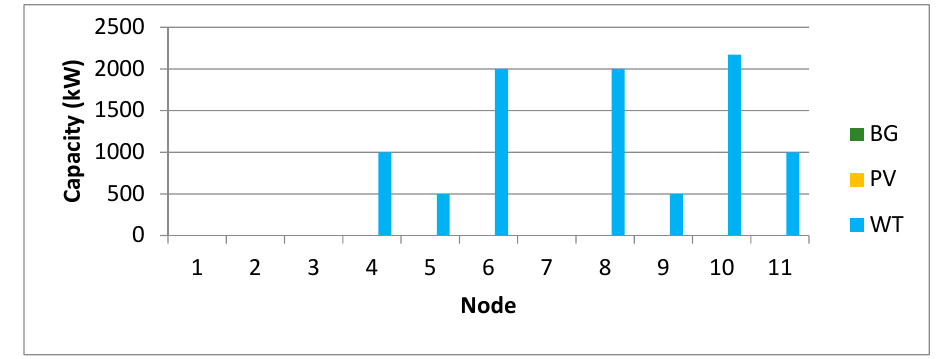
Figure A9. Capacity structure for 50% share of energy from RES in total demand with sizing and allocation of RES and EC.